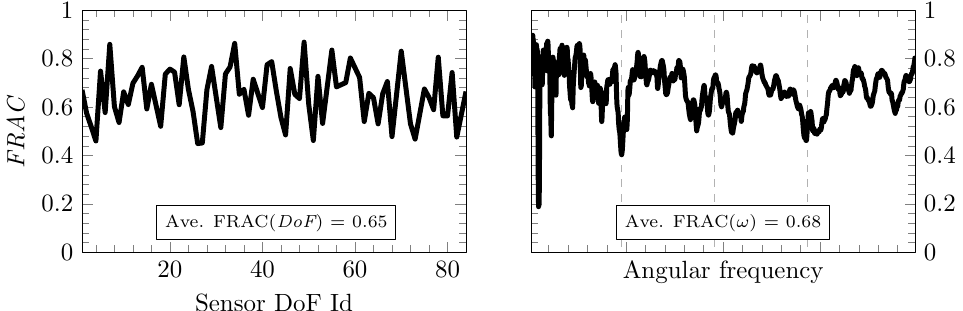
Figure 21. FRAC for the response spectra regarding the first run, considering all SPs and axes, evaluated in dependence on the DoF and